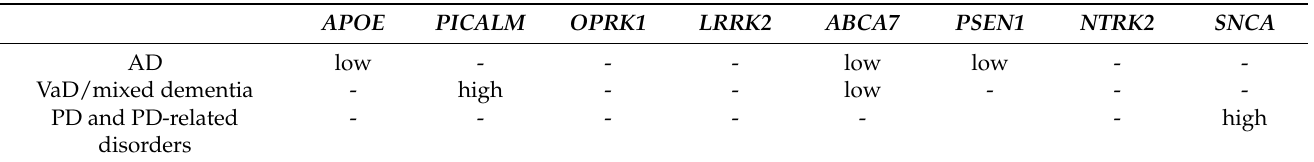
Table 3. Summary of gene expression